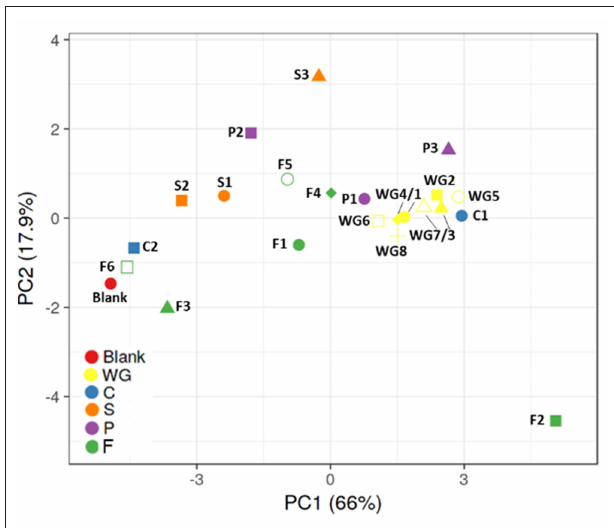
FIGURE 2 | Principal component analysis (PCA) plots representing metabolic (pH, gas, SCFA, BCFA, lactate) and qPCR (bifidobacteria, lactobacilli, Bacteroidetes, Firmicutes) data obtained for batch assays with fecal samples of three healthy donors exposed to control and 22 fiber products. BCFA, branched-chain fatty acid; SCFA, short-chain fatty acid. WG1, whole grain millet; WG2, whole grain oat; WG3, medium grain whole brown rice; WG4, whole grain soft white wheat; WG5, whole grain barley; WG6, whole grain corn; WG7, waxy whole grain soft white wheat; WG8, waxy hulless barley;